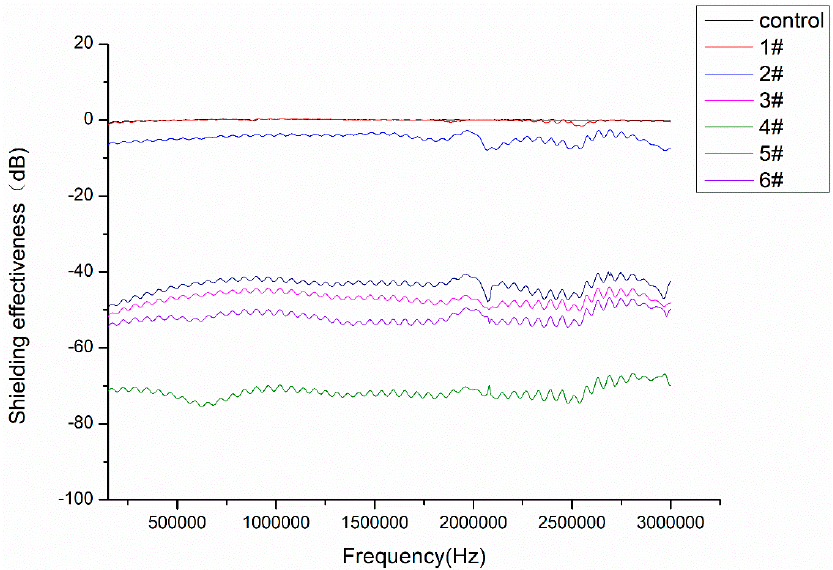
Figure 8. Shielding effectiveness for untreated and treated nonwoven polypropylene.